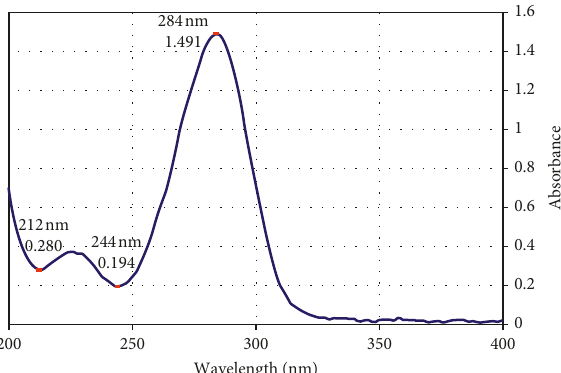
Figure 1: UV spectrum of 5-HMF in a fruit juice. Maximum absorption of the compound is observed to occur at 284nm, which may be indicative of the presence of